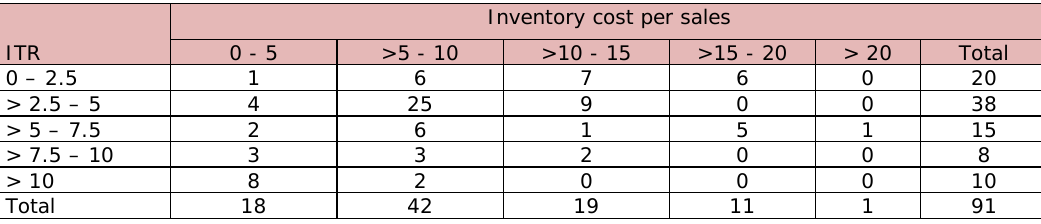
Table 12. “ITR and Inventory Cost per Sale”.